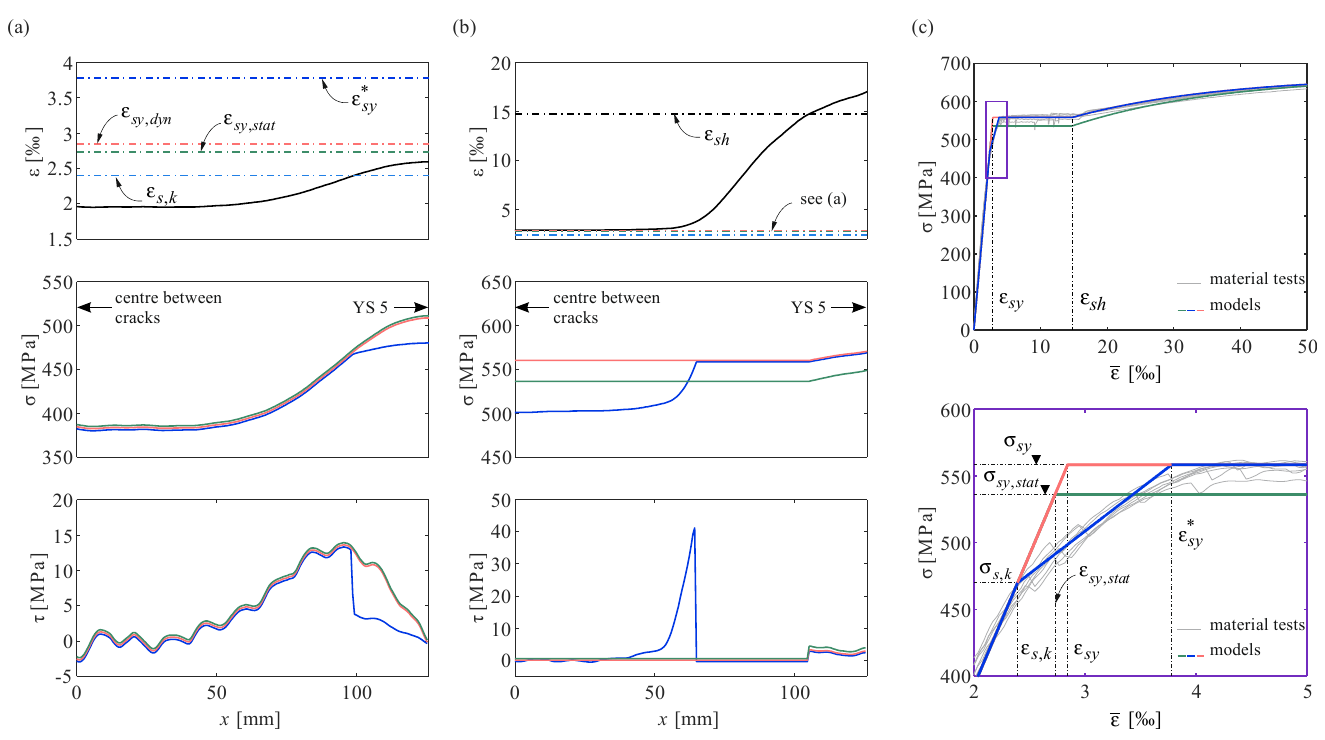
Figure 10. Derivation of normal steel and bond shear stresses from DFOS strain distribution in a half crack element using various idealisation for QST steel behaviour: ( a ) and ( b ) strains, normal and bond shear stress distribution at F = 150 and 178 kN, respectively, and ( c ) the used idealisations based on the material characterisation tests of the reinforcing bar (grey lines).